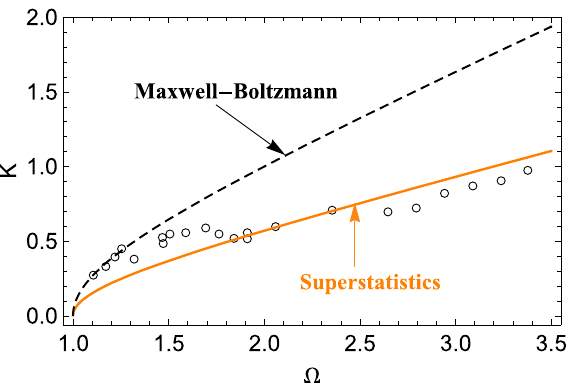
Figure 3. Comparison between the experimental data of Ref. 56 (open circles) and the best-fit obtained using the generic DR (25), corresponding to φ i ( q ) comparison (dashed